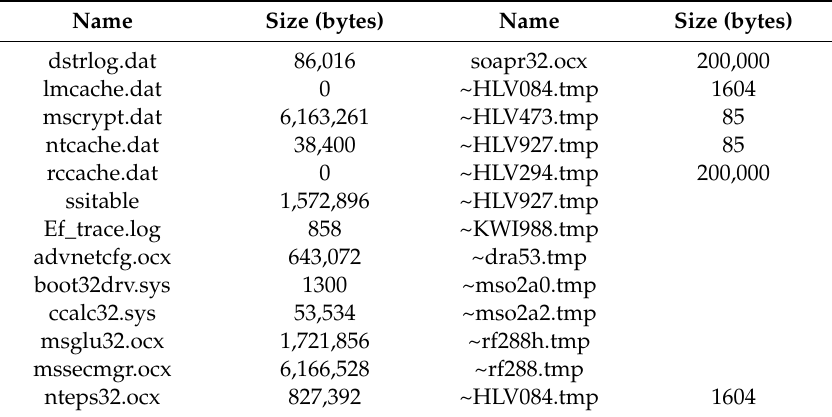
Table 12. Files created by malware